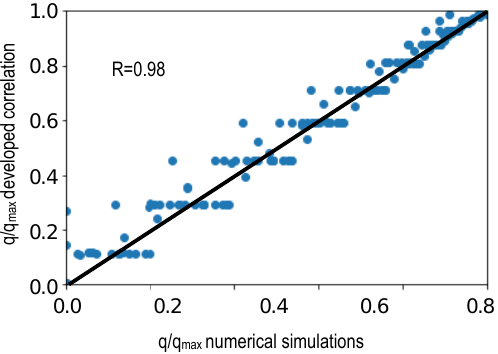
Figure 7. The correlation coefficient between the productivity of the modified empirical model and the numerical simulations.